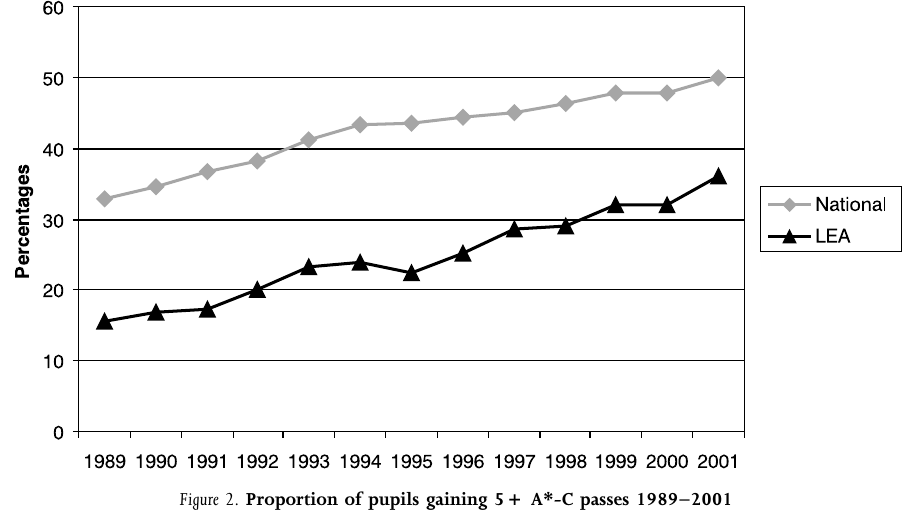
Figure 2. Proportion of pupils gaining 5+ A*-C passes 1989–2001